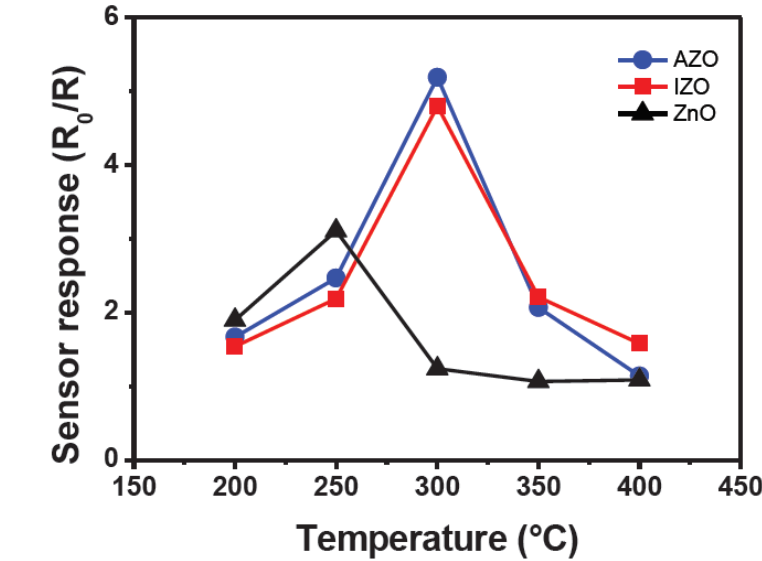
Figure 3. CO response of pure and doped ZnO nanoparticles as a function of the